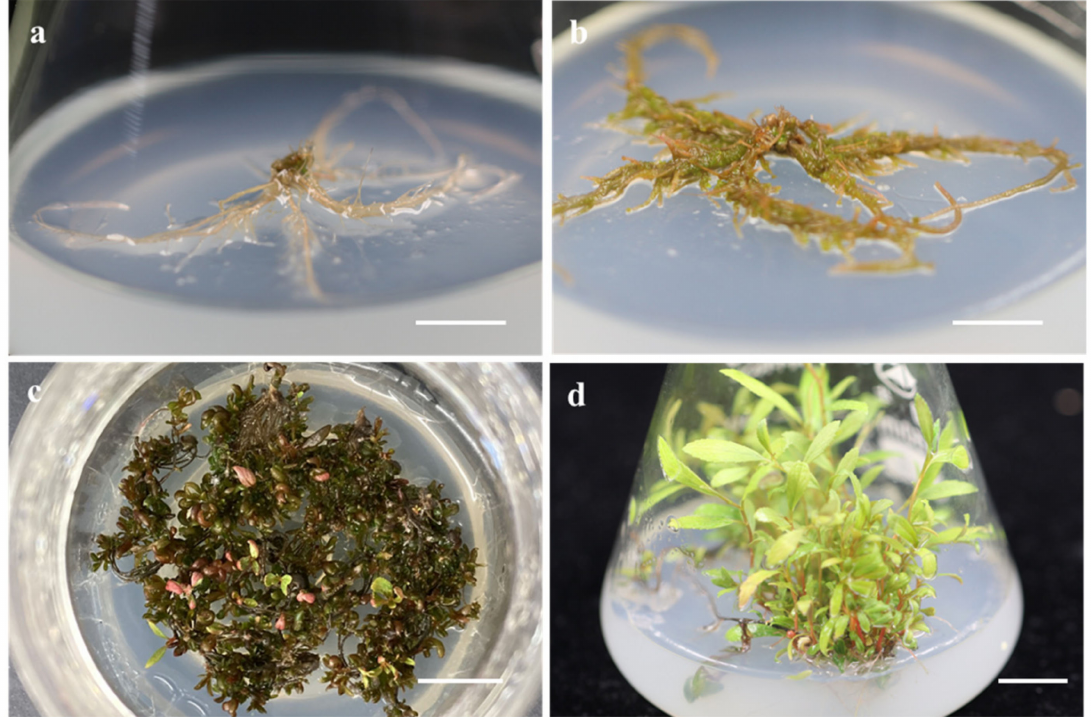
Figure 1. In vitro shoot induction and elongation from root explant of P. ussuriensis : ( a ) Root ex- plants as starting material. ( b ) Shoot induction is in progress. ( c ) Accomplished shoot induction. ( d ) Accomplished shoot elongation. Bars = 1.0